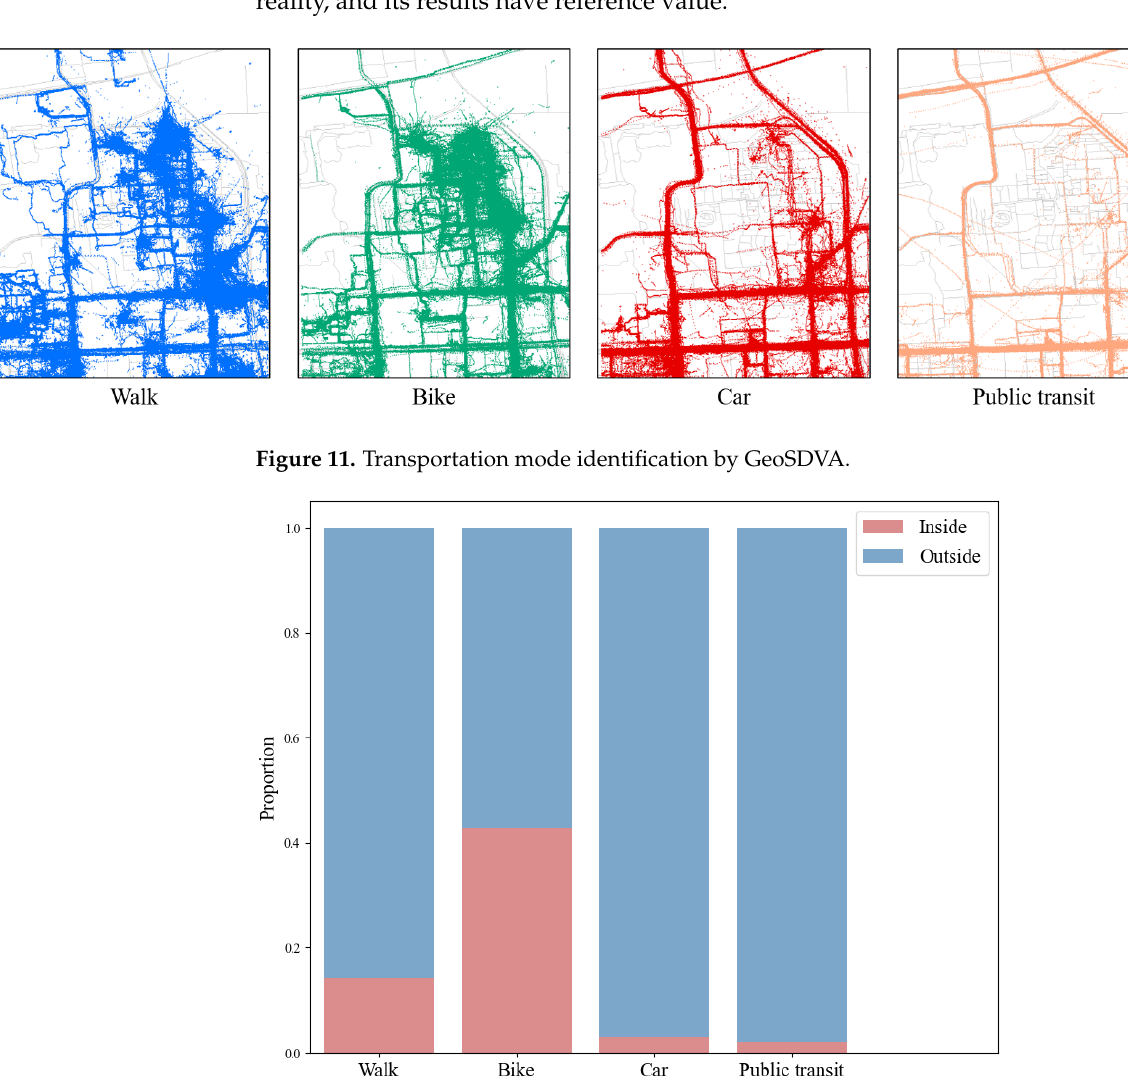
Figure 12. Transportation mode